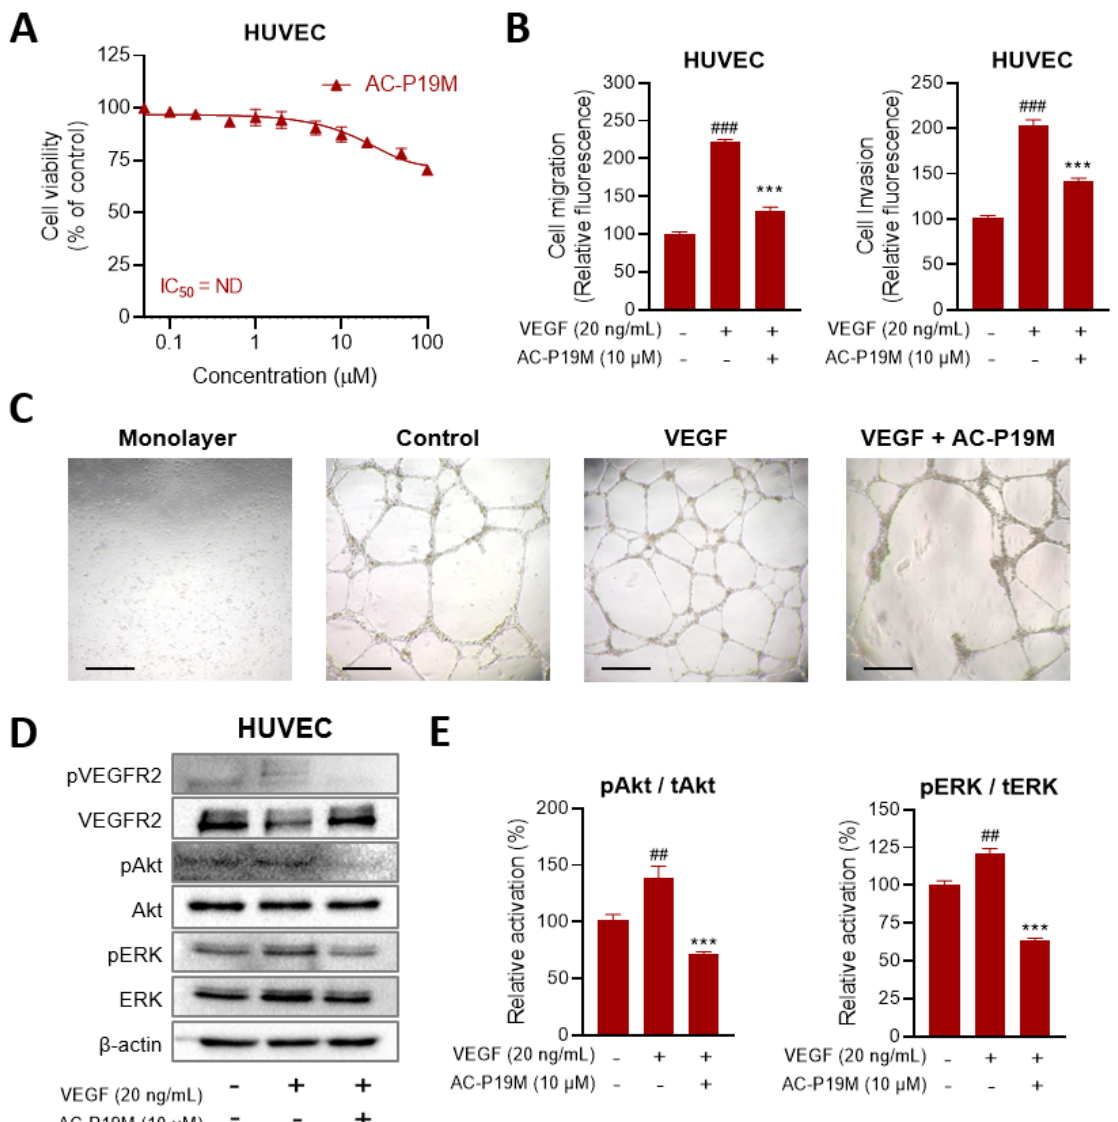
Figure 6. Anti-angiogenic activity of AC-P19M on HUVECs. ( A ) The relative cell viability of HUVECs upon AC-P19M treatment was confirmed in the concentration range of 0.1 µ M to 100 µ M. The peptide had no significant effect; the viability was maintained at more than 70% after peptide treatment at the maximum concentration. ( B ) The effects of VEGF and AC-P19M on cell migration and invasion were evaluated. VEGF increased the migration and invasion of HUVECs, but cotreatment with AC-P19M attenuated this effect. ( C ) The effect of AC-P19M on angiogenesis of HUVECs was observed by performing a tube formation assay. The absence of Matrigel led to the formation of a monolayer of HUVECs without tube formation. When the cells were incubated with 20 ng/mL of VEGF, the formation of the capillary structure was enhanced, along with the increased network and tube length. However, cotreatment with VEGF and AC-P19M resulted in the disruption of tube structure and branching with the aggregation of cells, demonstrating the anti-angiogenic activity of AC-P19M. The scale bar represents 100 μ m. ( D , E ) The activation of VEGFR2 signaling in HUVECs was measured by western blot analysis. Cotreatment of cells with VEGF and AC-P19M almost completely suppressed VEGFR2 phosphorylation compared with the VEGF treatment. Moreover, the downstream of the VEGFR2-signaling pathway was affected, where the activations of Akt and ERK were attenuated by AC-P19M treatment. Data are presented as the mean ± SEM. ##, p < 0.01; ###, p < 0.001 compared to the control group; ***, p < 0.001 compared to the VEGF-only treated group.